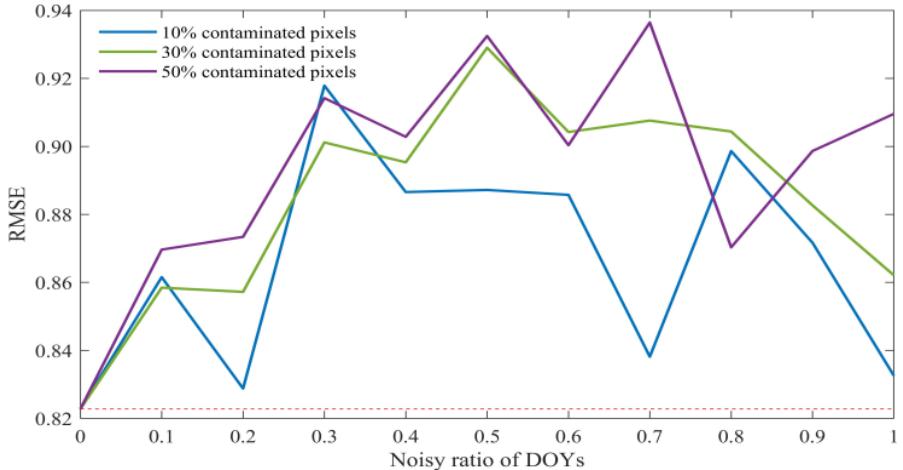
Figure 10. RMSEs of the LSTM fusion models based on the 10% (blue), 30% (green) and 50% (purple) noisy reflectance as training samples. The red dotted line represents the retrieval accuracy of the LSTM fusion model without noisy reflectance in the training dataset.